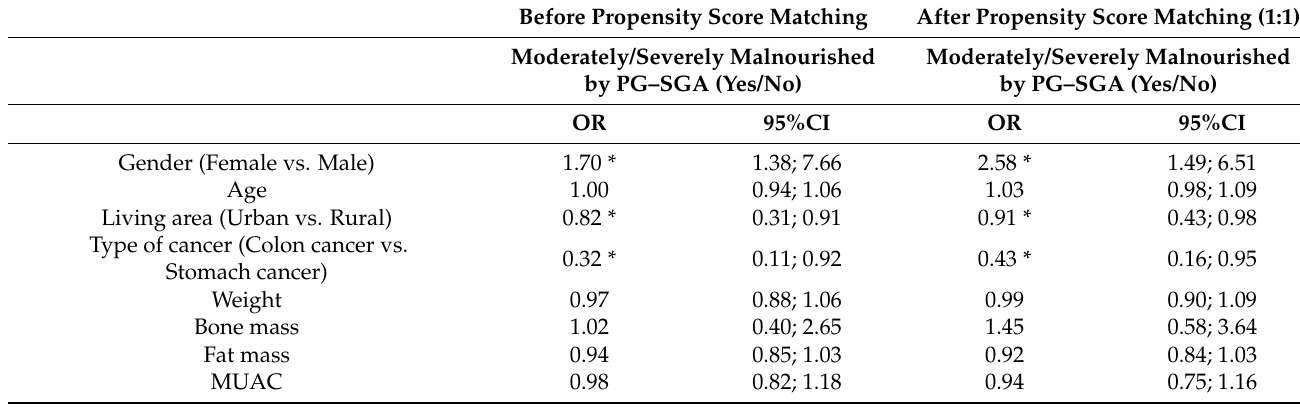
Table 5. Factors associated with being moderately/severely malnourished, assessed by PG-SGA before and after propensity score